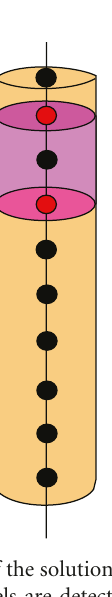
Figure 7: Schematic view of the fiber gap problem. Due to image noise or crossing fibers, tracing may terminate early and produce gaps in the segmentation. This can lead to multiple segmentation of the same fiber and therefore to wrong length distributions.